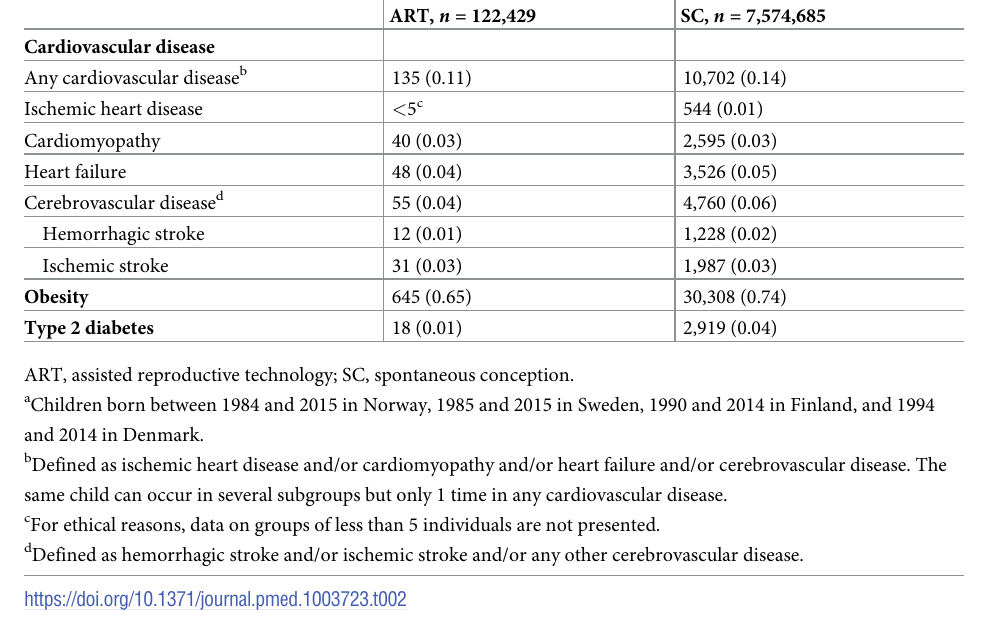
Table 2. Frequencies of cardiovascular disease, obesity, and type 2 diabetes in singletons born in Norway, Sweden, Denmark, and Finland between 1984 and 2015 a .